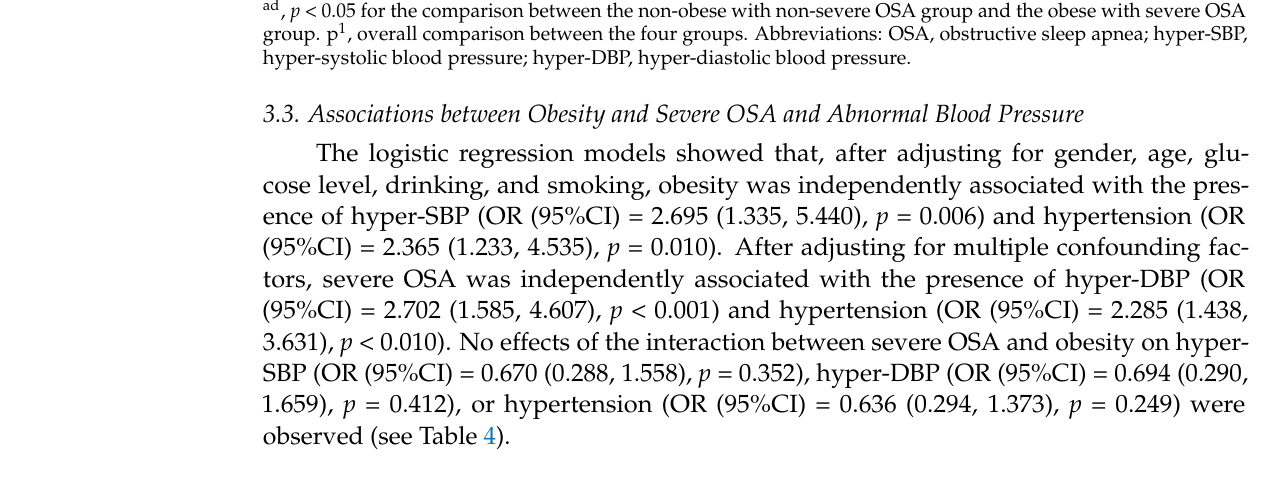
Table 4. Logistic regression models of selected factors and abnormal blood